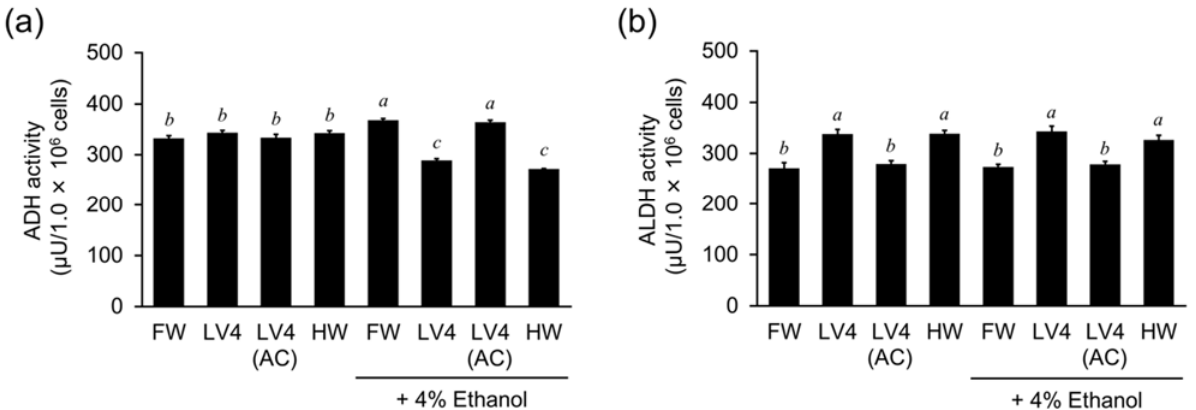
Figure 7. Effect of EHW on ADH activity and ALDH activity. ( a ) ADH activity and ( b ) ALDH activity in HepG2 cells cultured in the presence of filtered water (FW), untreated EHW LV4 (LV4) and autoclaved EHW [LV4 (AC)] and hydrogen rich water (HW) with and without ethanol treatment. The data represent the mean ± SEM ( n = 3). Data were analyzed by Tukey’s test after one-way ANOVA ( p < 0.05). Different letters above the bars indicate significant difference among treatments for each water with or without 4% ethanol.